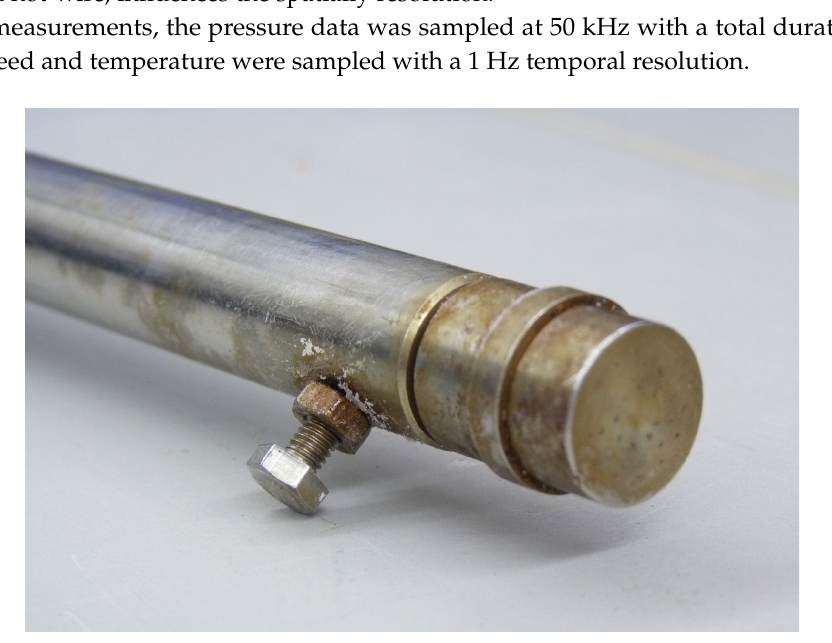
Figure 1. Pressure sensor after six months of offshore service (diameter = 12